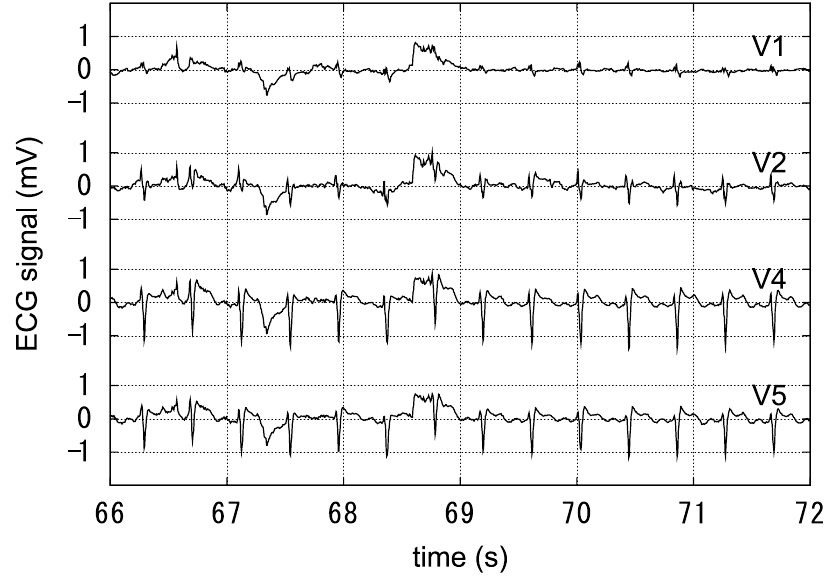
Figure 12. ECG signals measured by the smart shirt with the conductive foam blocks. The subject slowly jogged for 69 s and then rested in a standing position. The ECG signals became stable immediately when the subject stopped